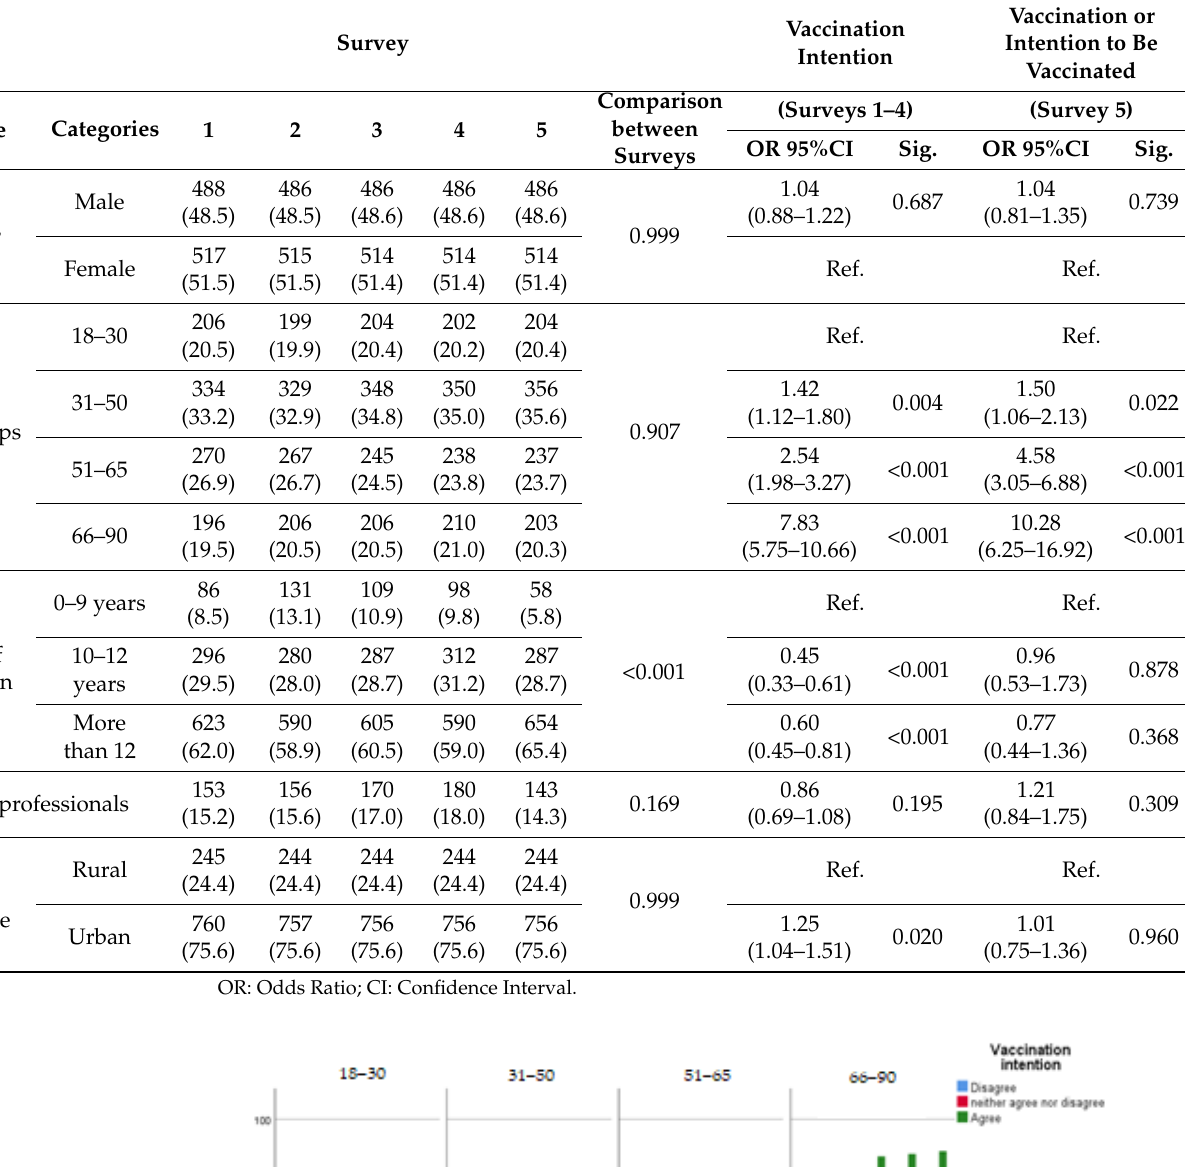
Table 1. Socio-demographic characteristics of the samples in each survey.